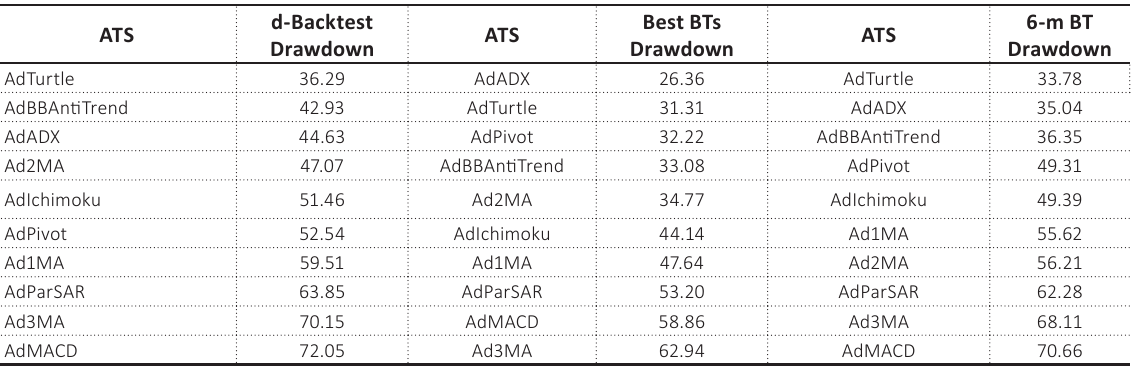
Table B3. Total results for Drawdown